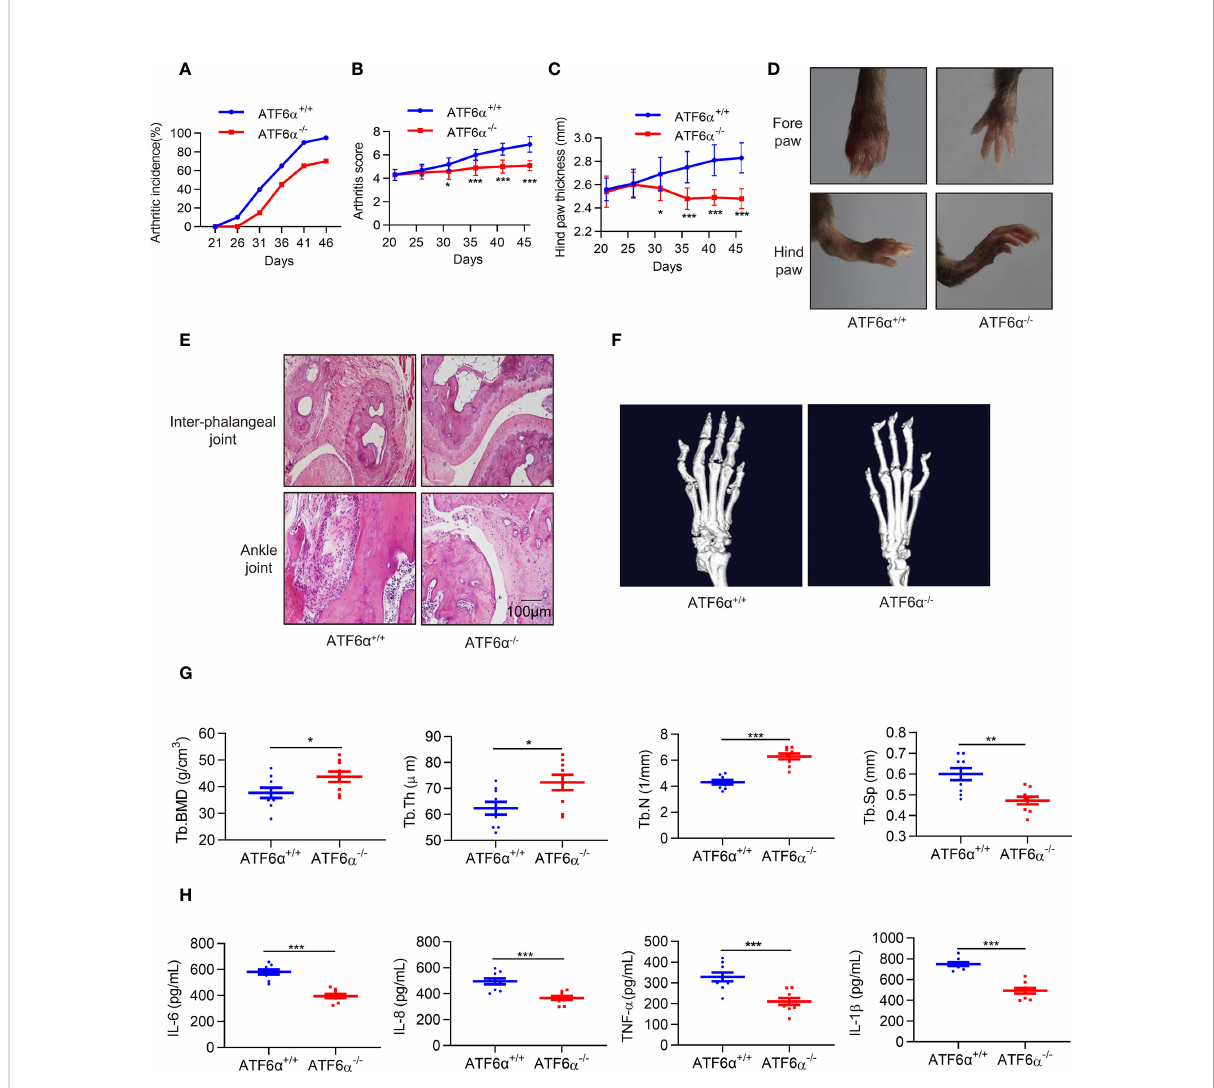
FIGURE 3 ATF6 a de fi ciency delays CIA development. (A – C) , Incidence, arthritis score, and hind paw thickness of CIA in WT and ATF6 a KO mice from day 22 to day 45. (D) , Representative photographs of the fore and hind paws of CIA in WT and ATF6 a KO mice on day 45. (E) , Representative H&E staining of inter-phalangeal joints and ankle joints. (F) , Micro-CT representative images of hind paws. (G) , Quantitative analysis results from micro-CT evaluation. (H) , IL-6, IL-8, TNF- a , and IL-1 b were measured in mice serum by ELISA. Data were expressed as mean ± SD ( n = 9) and analyzed using the non-parametric Mann-Whitney test (B) , two-way ANOVA analysis (C) , and two-tailed unpaired Student ’ s t test (G, H) . n represent biologically independent mice (A-C, G, H). * P < 0.05, ** P < 0.01, *** P < 0.001. Tb.Th, trabecular thickness; Tb.BMD, trabecular bone mineral density; Tb.N, trabecular number; Tb.Sp, trabecular